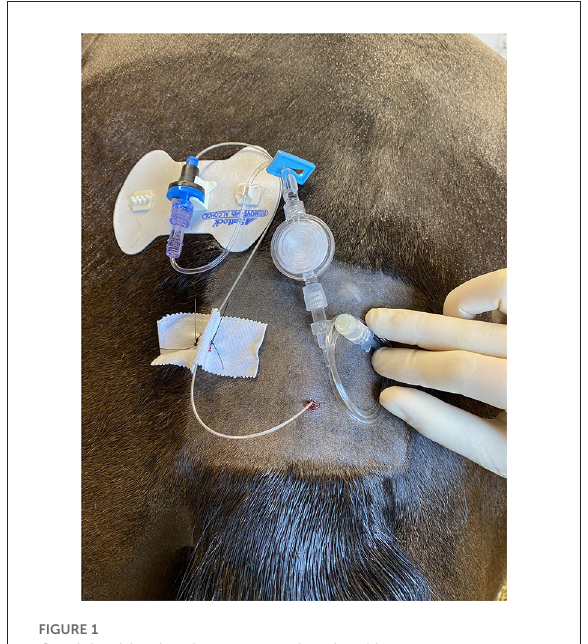
FIGURE1 Caudal epidural catheter secured to the